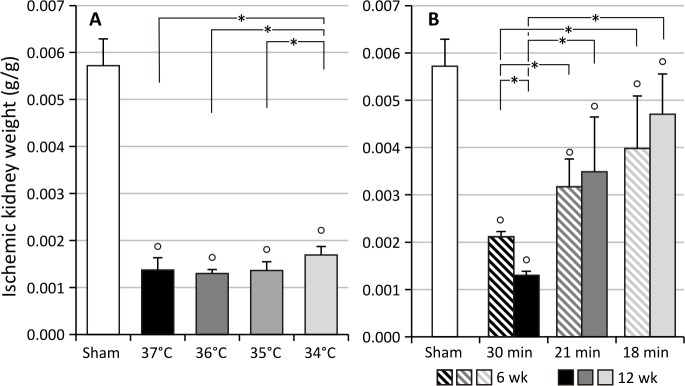
Ischemic kidney weight at euthanasia.Kidney weights are corrected for body weight. *: p<0.05, °: p<0.05 vs. Sham. A: UIRI was performed for 30 minutes at 37°C (n = 5), 36°C (n = 4), 35°C (n = 10) or 34°C (n = 5) and animals were euthanized 12 weeks after UIRI. UIRI results in a significant reduction of renal mass (p<0.05) at all temperature conditions tested. B: UIRI was performed for 30, 21 or 18 minutes at 36°C and animals were euthanized 6 weeks (resp. n = 5, n = 12, n = 6) and 12 weeks (resp. n = 4, n = 5, n = 10) after UIRI. UIRI causes an ischemia time-dependent reduction in renal mass, with a significantly more severe reduction in renal mass with longer ischemia times. The bars are the means ± s.d. The data were analysed using a two-tailed Mann-Whitney U test.